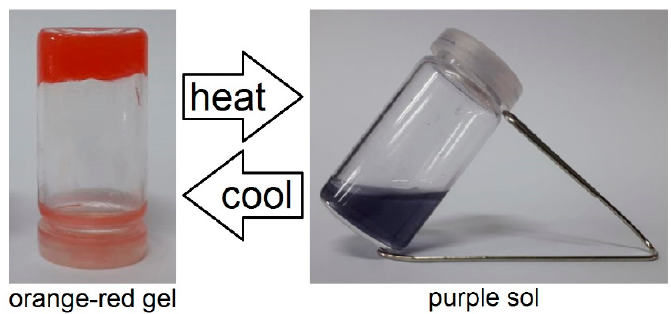
Figure 3. Normalized UV–Vis absorbance spectra of UTCFH (0.06 wt%) in DMSO at different temperature values; 44 °C (yellow at 442 nm), 51 °C (orange at 490 nm), 57 °C (red at 505 nm), and 63 °C (purple at 535 nm).